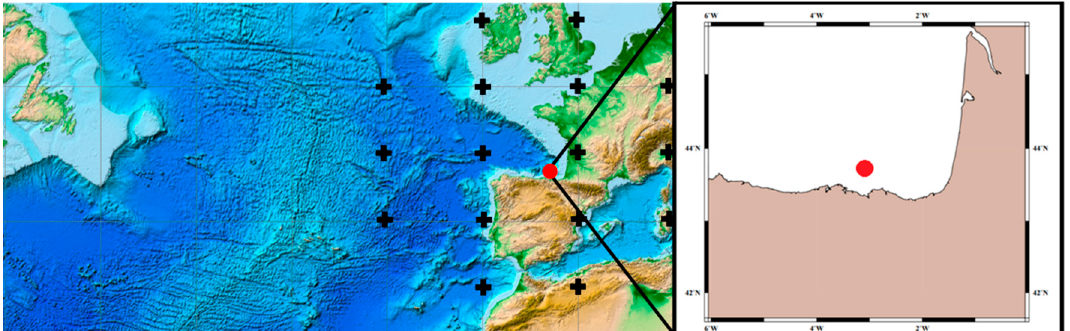
Figure 1. Location of the study area ( left ) and the Bilbao-Vizcaya buoy ( right ). Crosses on the left display the grid nodes used for the extraction of the atmospheric indices following the Jenkinson and Collison method (1977) [21]. A red dot on the right indicates the location of the Bilbao-Vizcaya buoy. Data used in this research come from several sources (Table 1). Observed wave records